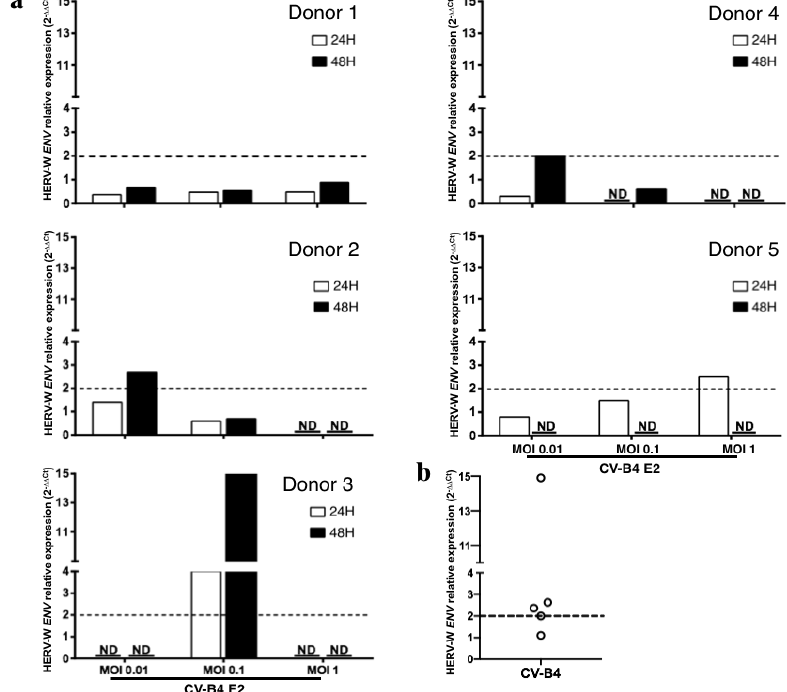
Figure 2. Human Endogenous Retrovirus W Envelope (HERV-W ENV ) mRNA expression in primary human pancreatic ductal cells infected by Coxsackievirus B4 (CV-B4). Pancreatic primary cells obtained from five brain-dead donors were infected with CV-B4 E2 (multiplicity of infection (MOI) 0.01, 0.1 or 1). Total RNA was extracted from the cells with TriReagent, and the level of intracellular HERV-W ENV mRNA in each culture was assessed using RT-qPCR normalized with the level of beta-actin mRNA.Each result is the mean of two or three determinations; furthermore, each RT-PCR datum is the mean of two technical duplicates. The relative expression of HERV-W ENV mRNA in CV-B4 E2 infected cultures compared with that in mock-infected cultures was calculated using the 2 −ΔΔCt method. ( a ) The individual relative expression of HERV-W ENV for each culture is shown. ND: not done due to an insufficient number of cells. ( b ) The maximum individual relative expression of HERV-W ENV for each culture is shown. The dotted line indicates a relative expression of 2.